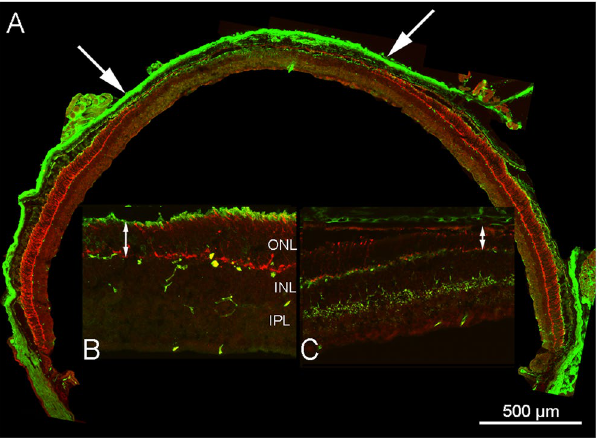
Figure 2. Retinal morphology 7 days post induction. Vertical section of a complete eye cup from a Tvrm4 mouse exposed to 12,000 lux for 1 min and examined after 7 days. Red: cone arrestin; green: light sensitive channel staining. The central area devoid of photoreceptors (between the two arrows in (A) is highlighted by the drastic reduction of both rod and cone markers, totally undetectable. (B and C) higher magnification images of a preparation similar to A. (B) same staining as in A, showing the decreasing thickness of the ONL (double arrow). (C) cone arrestin (red) and synaptotagmin staining (green) show cone bipolar cells whose axons form a thick plexus in the inner plexiform layer (IPL; on the contrary, the ONL is progressively thinning (double arrows) and cones (red) become gradually